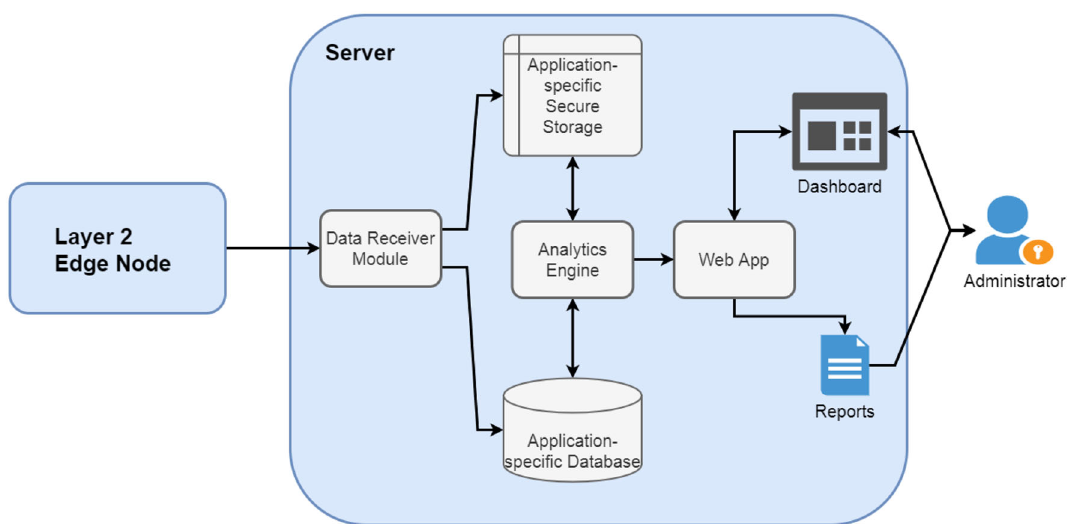
Fig. 5 High-level architecture of the server-side application